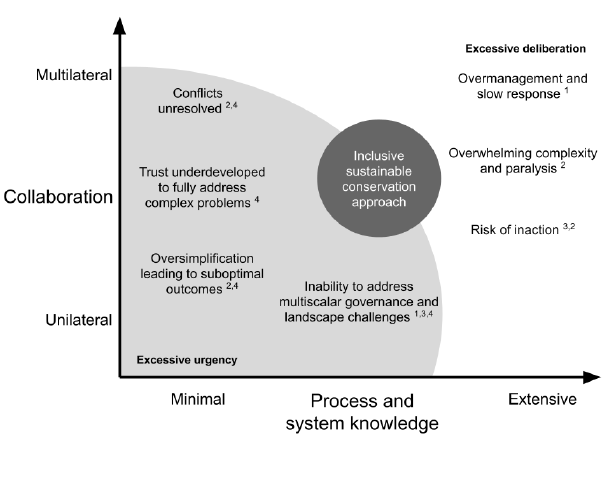
actions. Research emphasizes that conservation